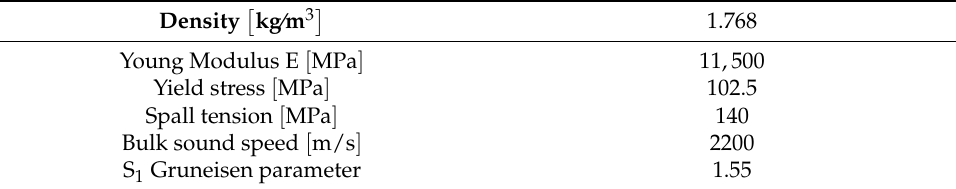
Table 2. ATJ graphite proposed material